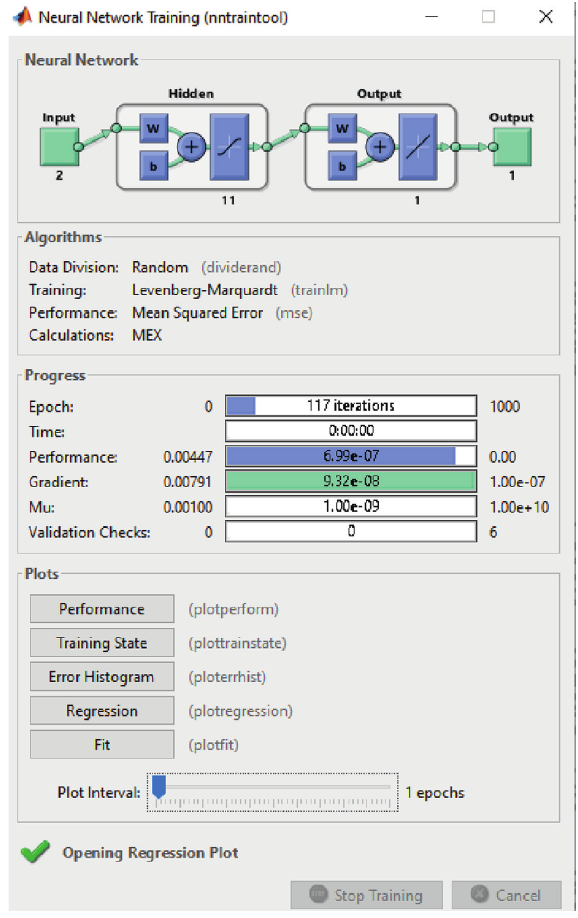
Figure 42: Neural training with NNET tool.